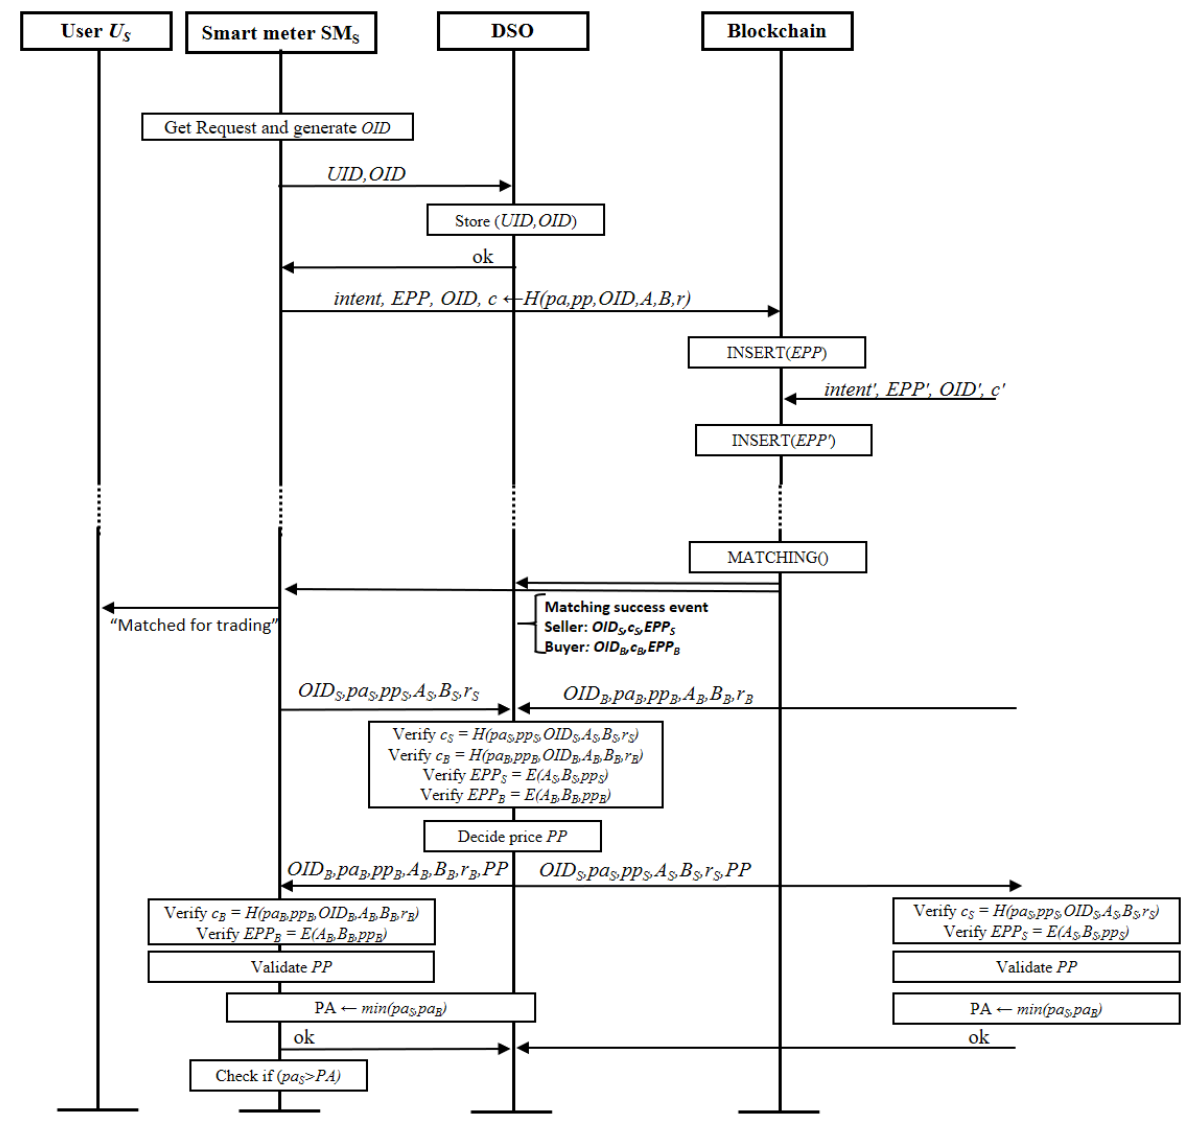
Figure 8. Bidding and matching